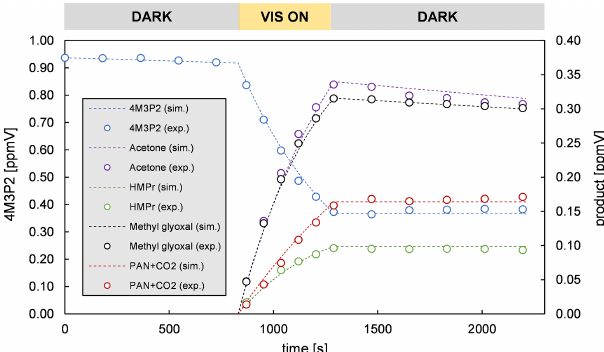
Figure 8. Experimental and simulated time profiles obtained for a 4M3P2 + OH